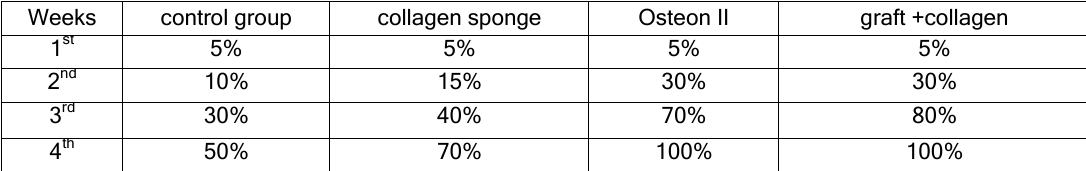
Table (1): The healing % for the treated animals by using the four different agents for 4 weeks.